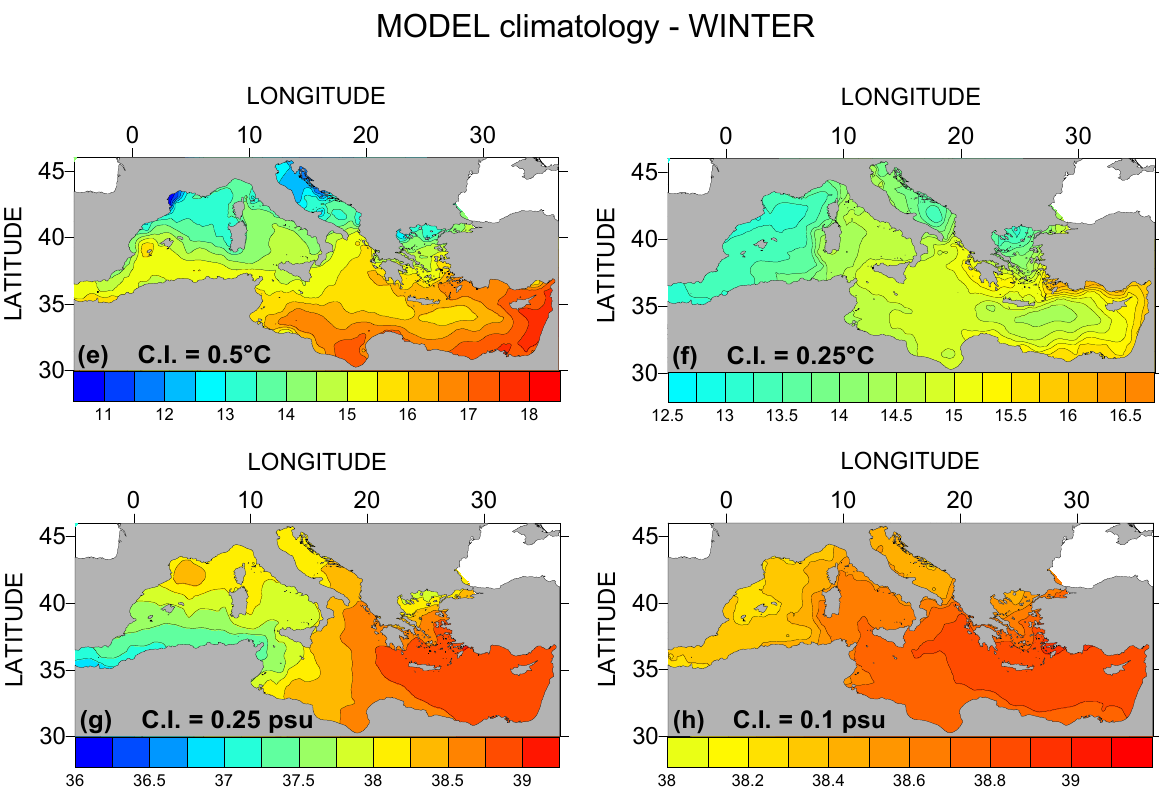
Fig. 2. Winter MED6 and model climatological fields at 50m and